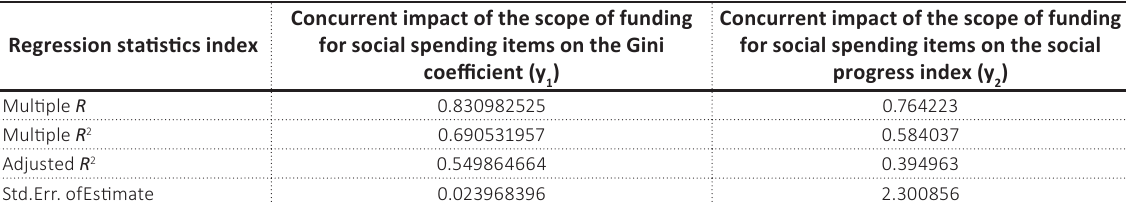
Table 8. Regression statistics for the concurrent impact of the scope of funding for social spending items on social